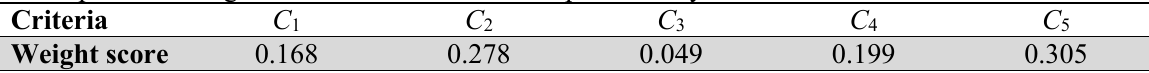
The importance weights of the lecturers’ research productivity evaluation criteria Criteria